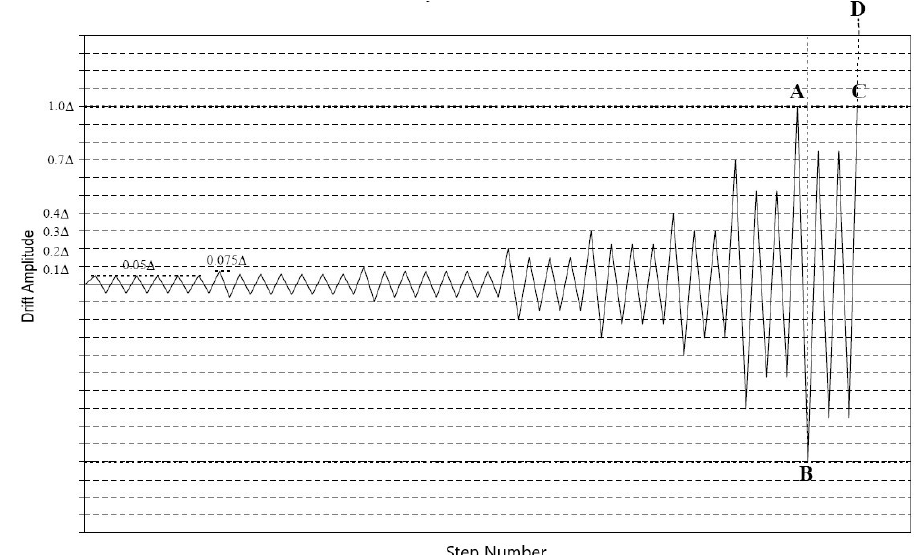
Figure 7. Loading history for basic deformation controlled quasi-static cyclic test [83].